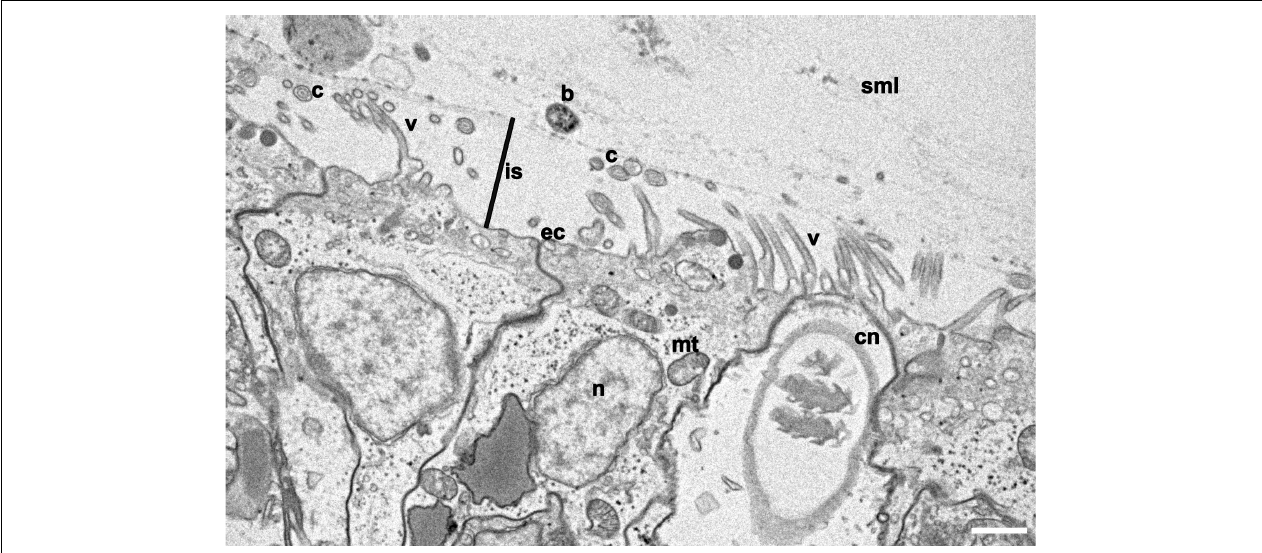
FIGURE 2 | Cross section of the surface ectoderm of Aiptasia. Representative transmission electron microscopy (TEM) micrograph of Aiptasia shows the villi coverage on the epidermis and the interspace between villi and the surface mucus layer (SML), where a bacterium can be identified. b, bacterium; c, cilia; cn, cnidocyte; ec, ectoderm; is, Ectoderm-mucus interspace; mt, mitochondria; n, nucleus; sml, surface mucus layer; v, villus. Scale bar- 1 µ